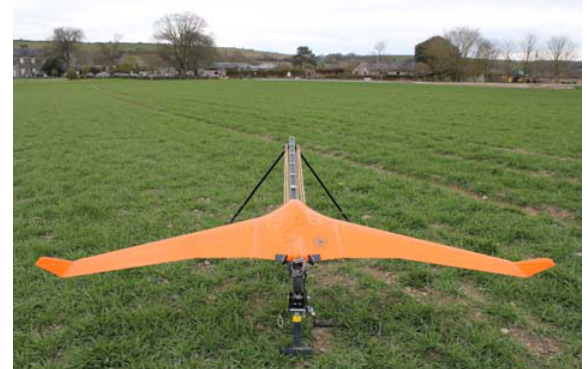
Figure 3: The C-Astral Bramor UAV on the catapult ready for launch.